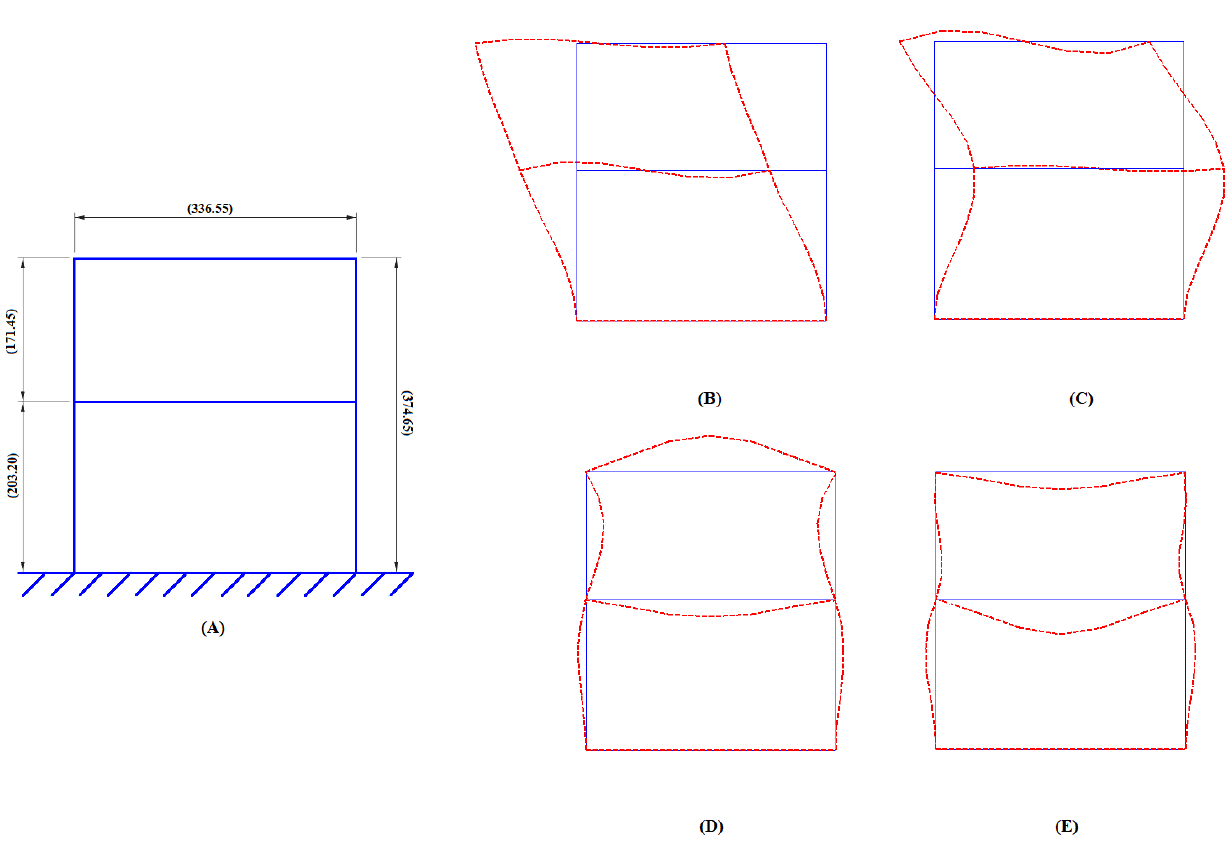
Figure 1. ( A ) Undeformed frame structure (all dimensions are in mm), ( B – E ) first four eigenmodes. Table 1. Analytical FEM based first 4 natural frequencies in Hertz. Mode Number